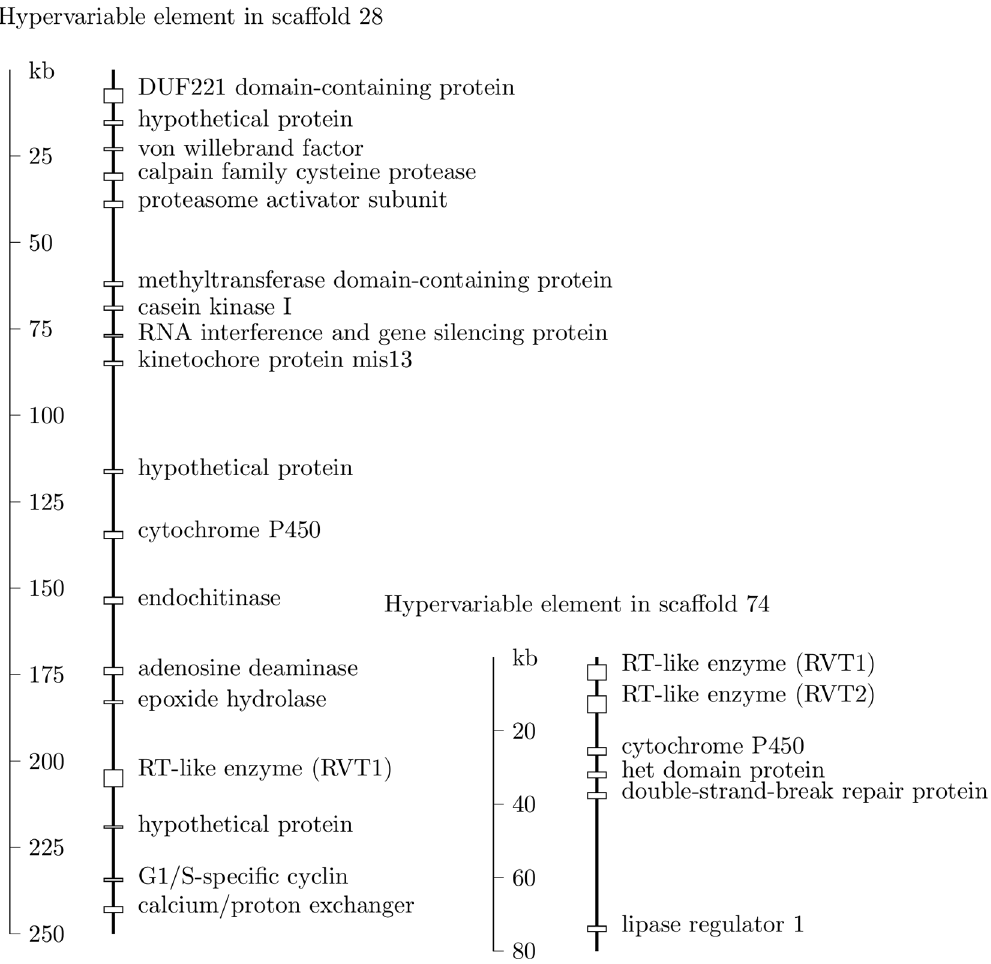
G1/S-specific cyclin